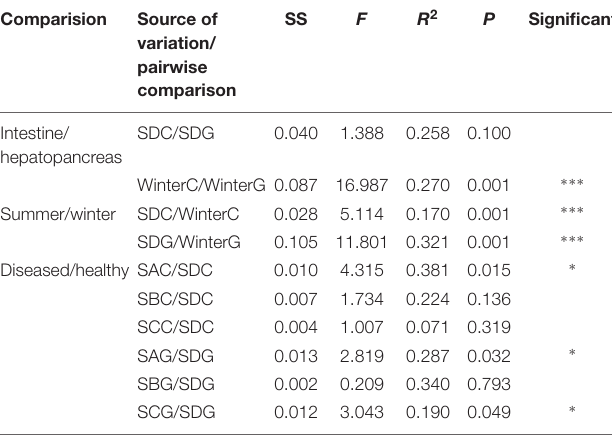
TABLE 2 | PERMANOVA results based on Bray–Curtis